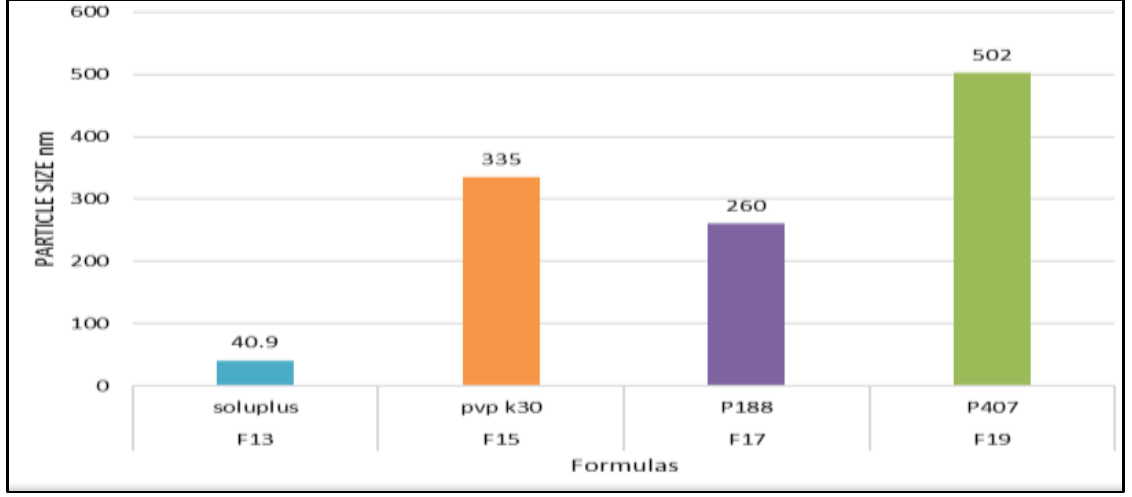
Figure 3. Effect of polymer type when using acetone on particle size for F13, F15, F17, and F19